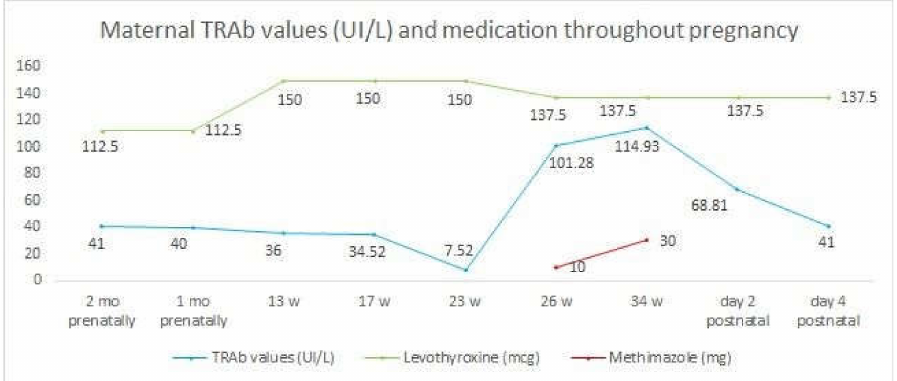
Figure 2. Maternal TSH values before pregnancy, throughout pregnancy and postnatally as compared to normal TSH values in pregnant and non-pregnant women The maternal TSH values were monitored before and during the pregnancy, with a monthly frequency at the beginning of the second trimester; further, with the appearance of the ultrasonographic signs of fetal thyrotoxicosis, the monitoring frequency increased. The TSH values had a descending tendency with the advancing pregnancy.